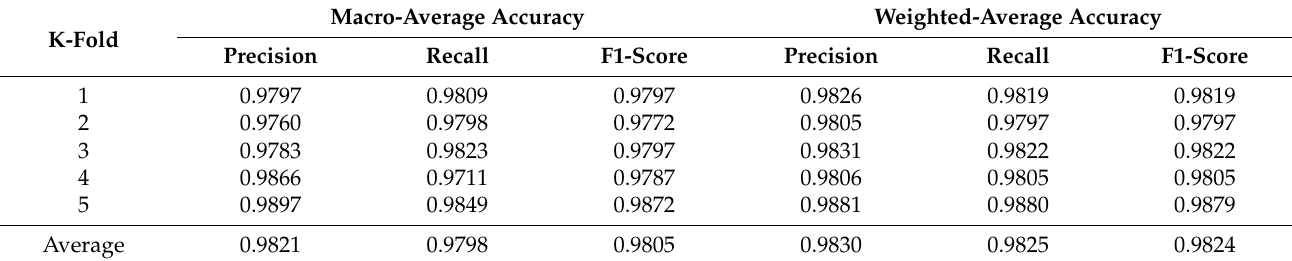
Table 2. Result of K-Fold cross-validation for the CNN